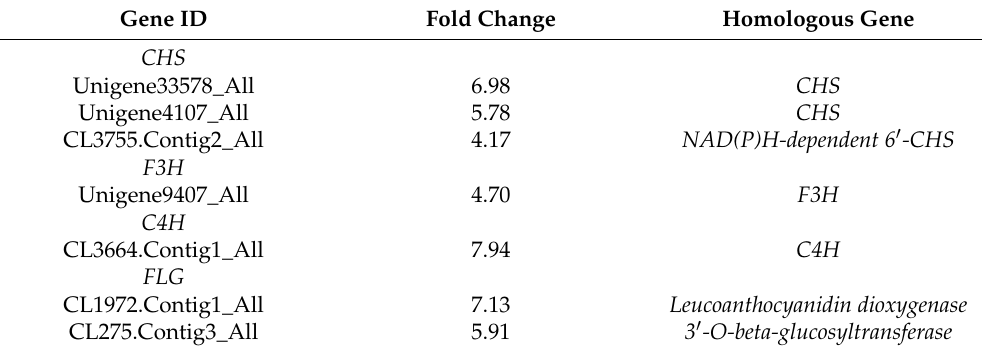
Table 8. The upregulated DEGs related to flavonoids in the leaves of A. canescens under 100 mM NaCl, but not under control conditions, for 24 h.